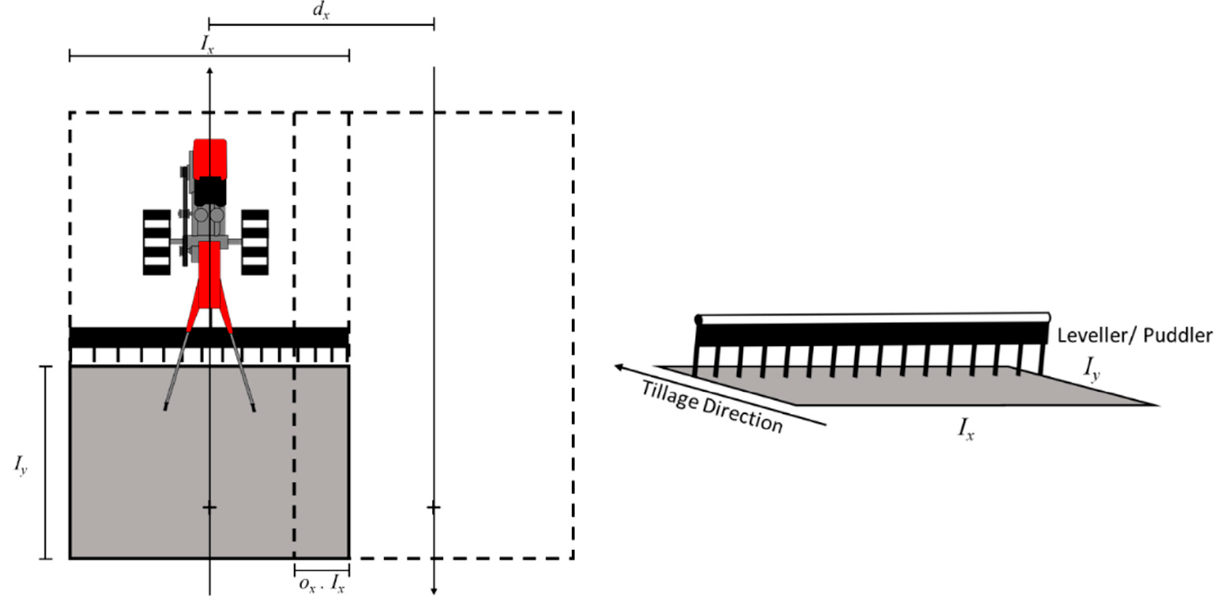
Figure 2. Walk-behind hand tractor tillage mission from a perspective view. The top perspective is depicted on the left. Lines with arrows indicate the direction of tillage. The gray box denotes the area crossed by the puddler, referred to as the Tl(p) tillage footprint. After completing one tillage line, the tractor will proceed to the next. dx denotes the distance between tillage lines. The right image depicts a view from a lateral position.